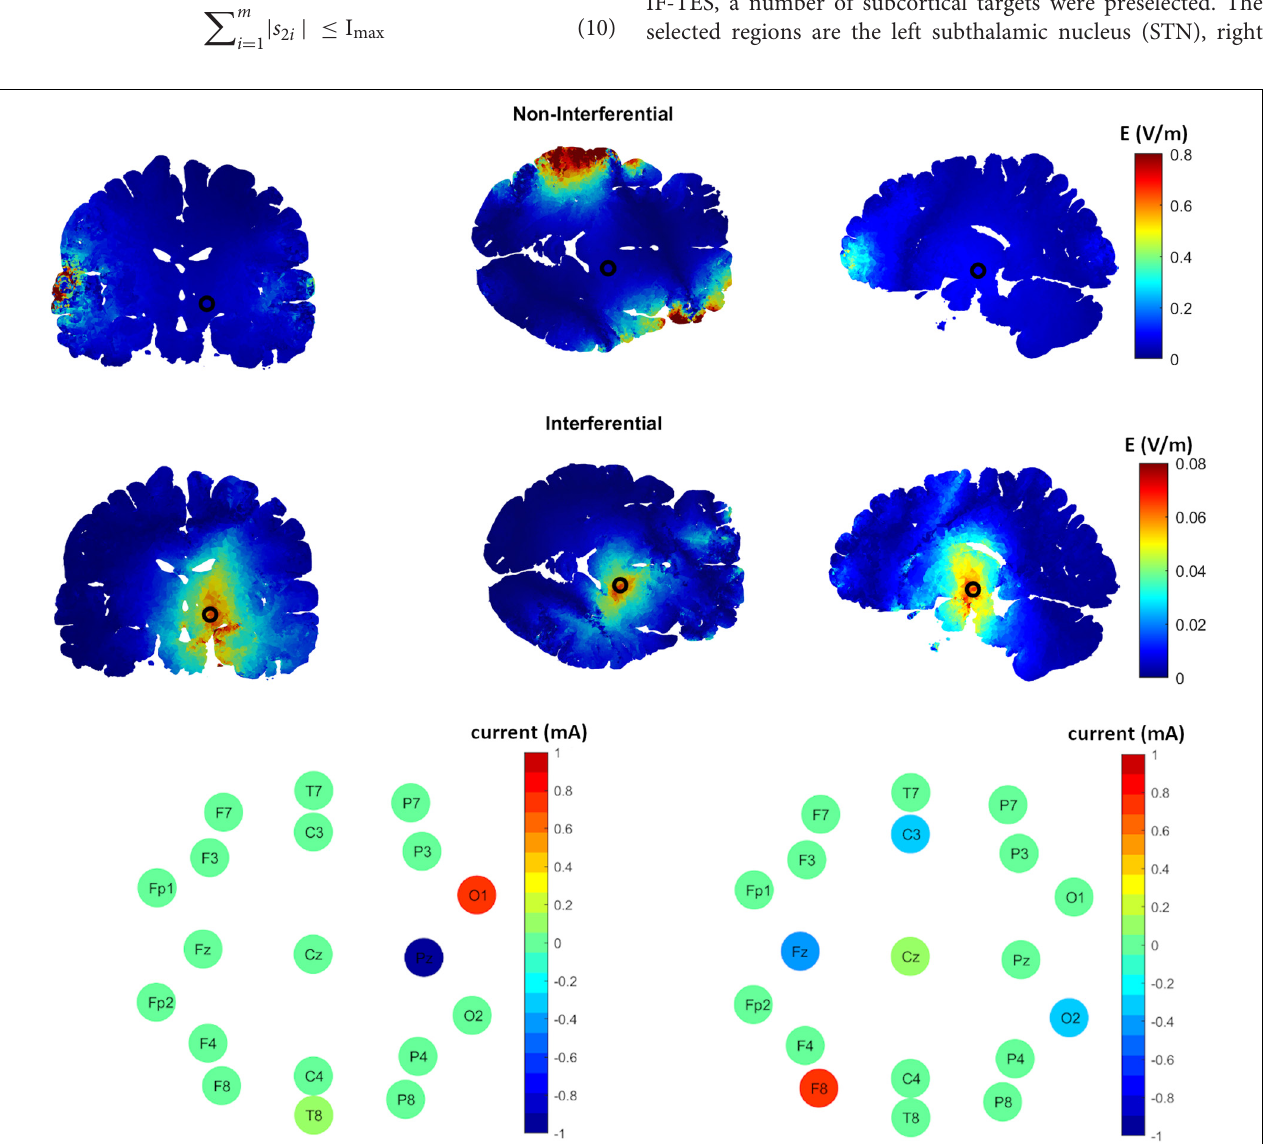
FIGURE 1 | The distribution of the induced interferential and non-interferential electric fields and their corresponding electrodes configuration to target the subthalamic nucleus (STN) using epicranial electrodes. The first row shows the high frequency non-interferential electric field distribution along different brain sections (from left to right, coronal, axial, sagittal). As shown, the highest electric field values are on the cortex under the stimulation electrodes with much weaker fields at the center of the STN (indicated by black circle). On the other hand, the interferential fields (row two) show the strongest values at the target and weaker ones at non-target regions. The third row displays the corresponding optimal electric current distribution along the different electrodes for each of the two sources s1 (left panel) and s2 (right panel) .